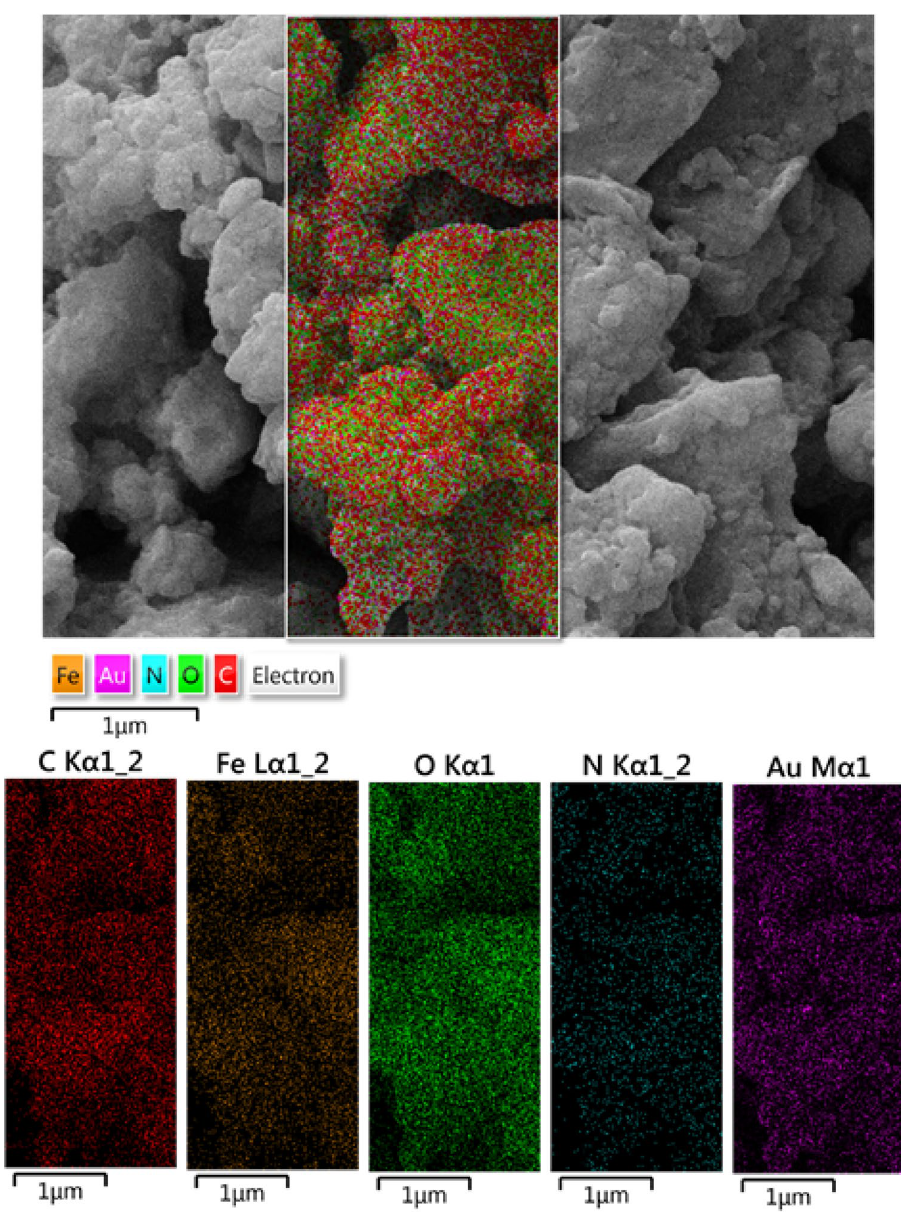
Figure 4. Elemental mapping of GO/Fe 3 O 4 @PDA/Au